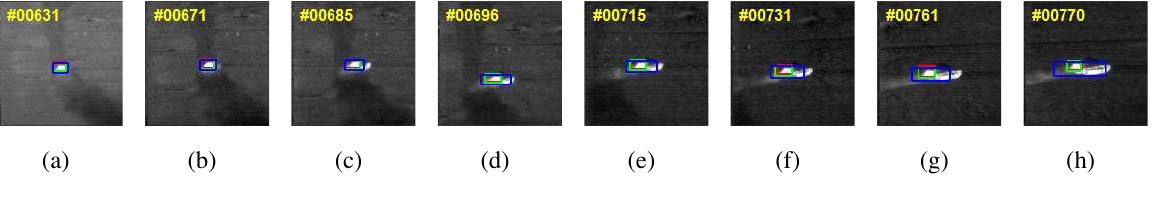
Figure 2. Tracking results of three trackers for sequence LW-17-20.